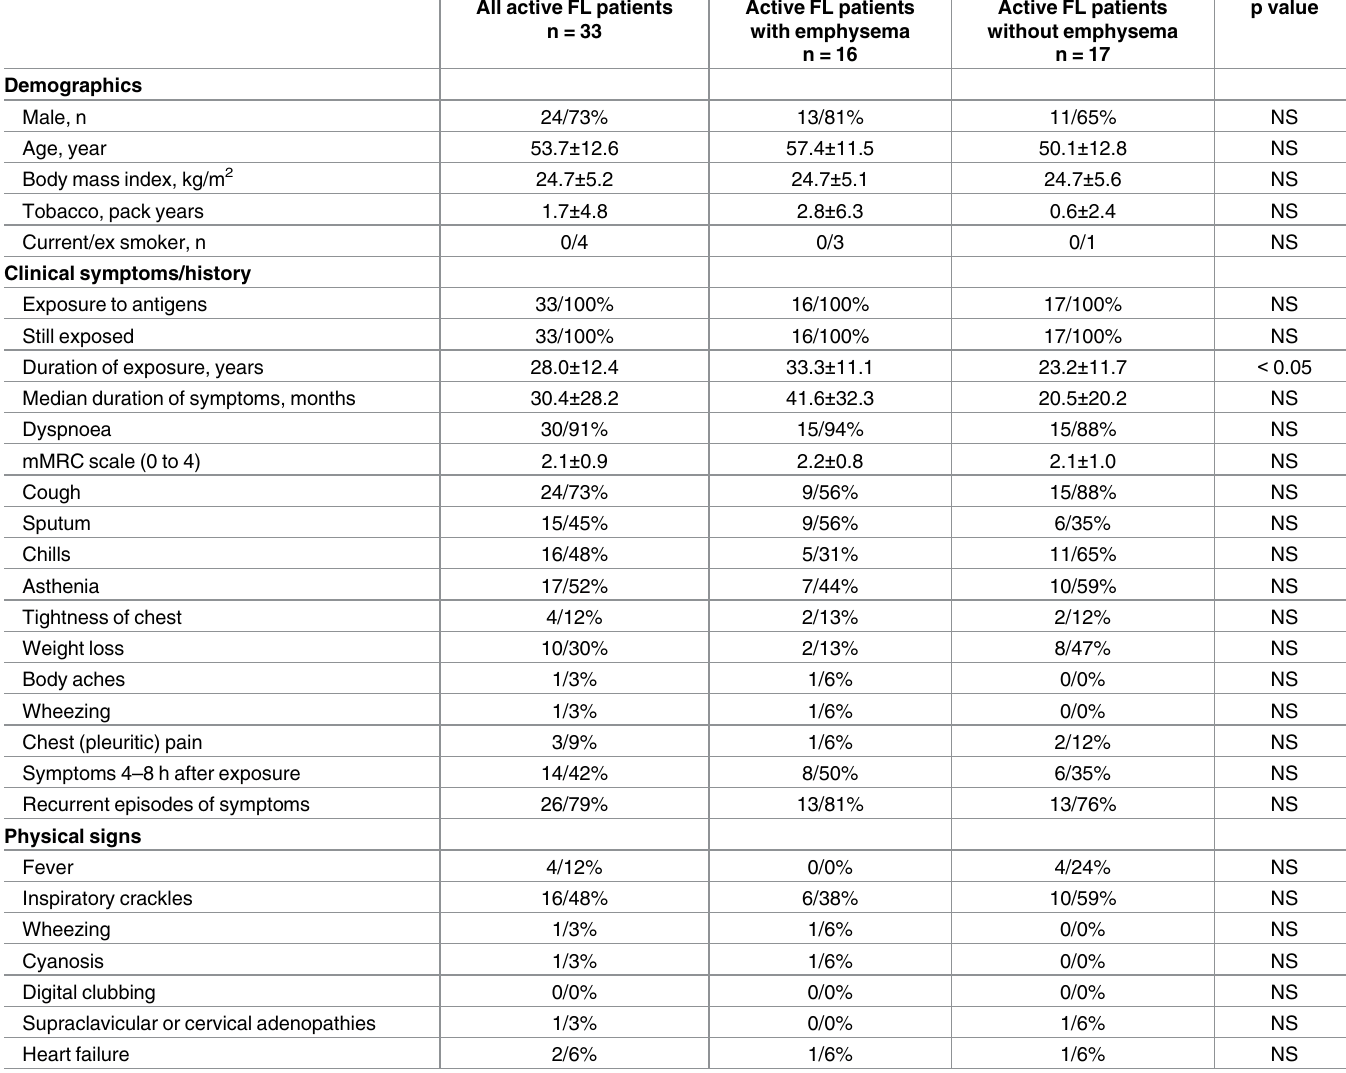
Table 1. Characteristics, respiratory symptoms and physical signs in patients with active farmer’slung